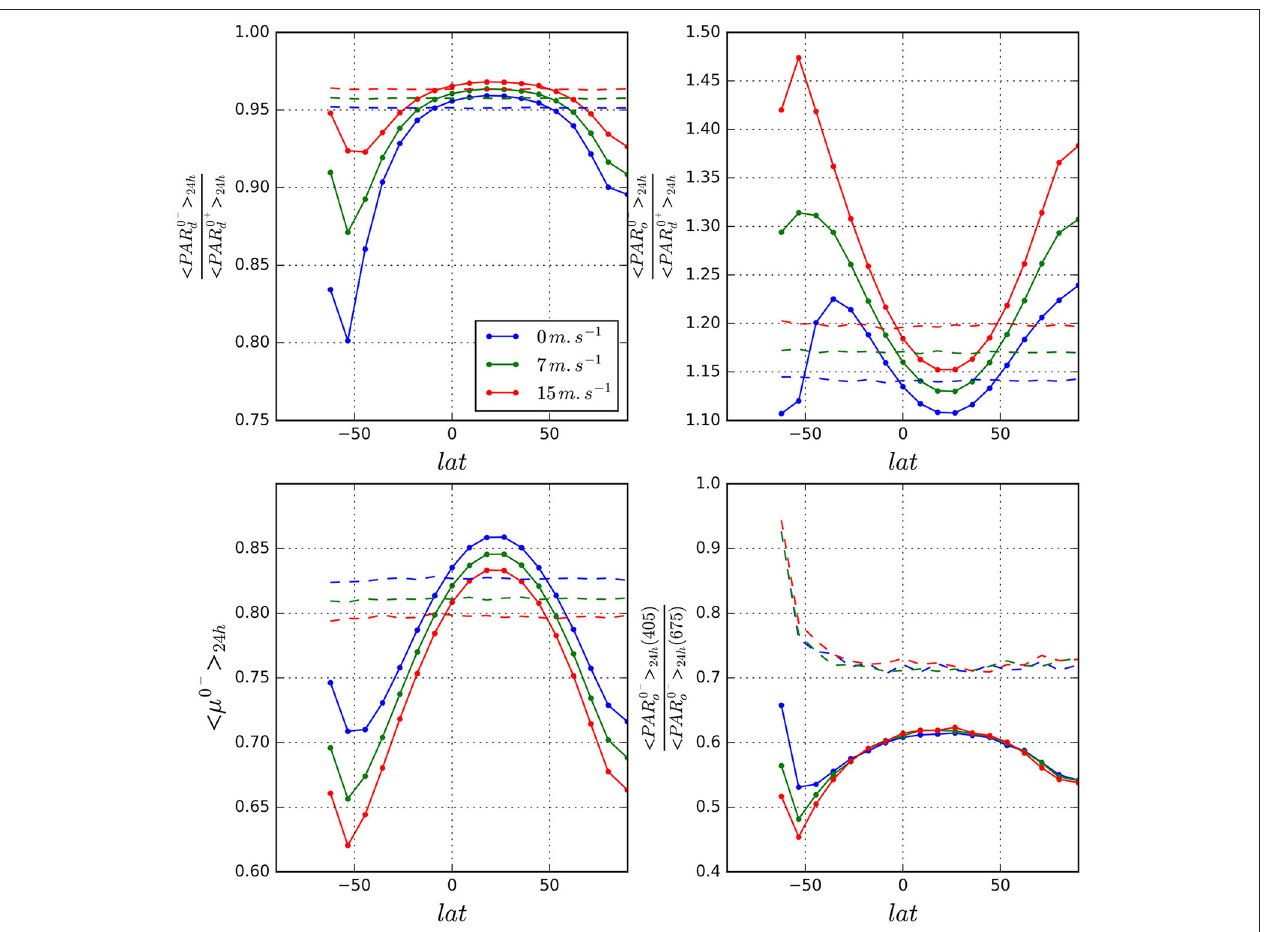
FIGURE 11 | Simulations of 24h averaged secondary radiative products for clear-sky (solid lines) and totally overcast situations (dashed lines, cloud optical thickness = 50, constant along the day) and for several wind speed as a function of latitude. (Top left) Ratio of planar PAR below and above surface. (Top right) Ratio of scalar PAR below the surface to planar PAR above surface. (Bottom left) Average cosine below the surface. (Bottom right) Ratio of spectral scalar PAR below the surface at 405 and 765nm. The date is 21st of June. smooth the product, which becomes a simple function of latitude.